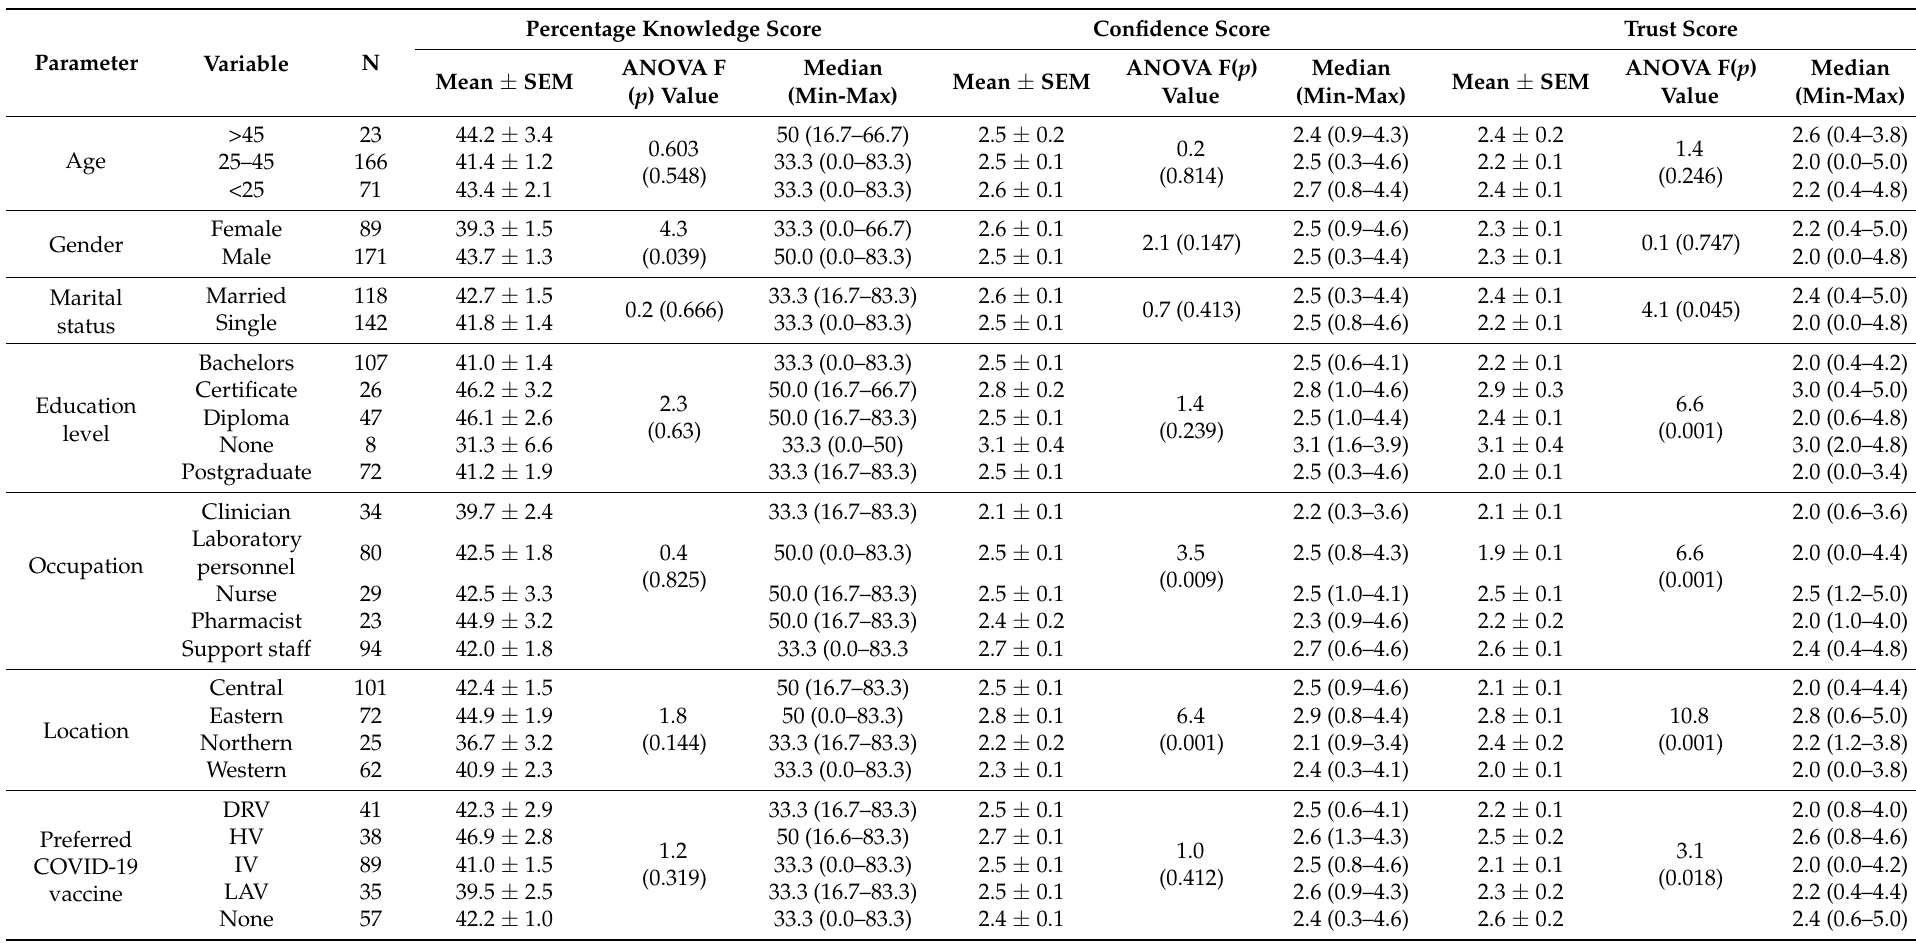
Table 2. Sociodemographic variables associations with knowledge, confidence and trust on COVID-19 vaccine clinical trials in